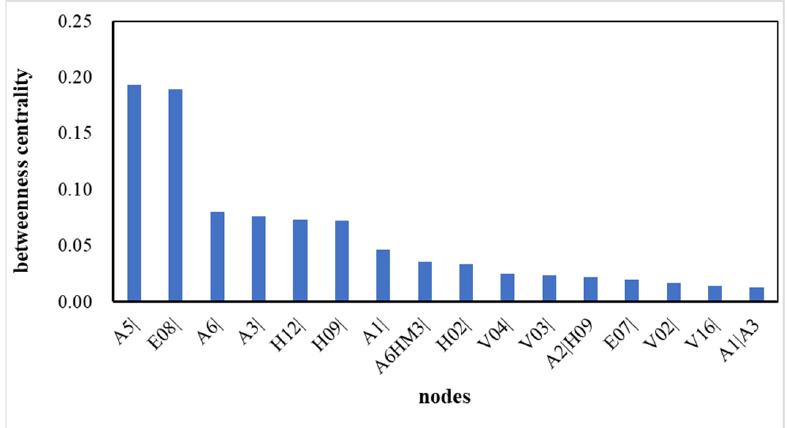
Figure 8. The betweenness centrality of the nodes whose values are greater than 0.01.